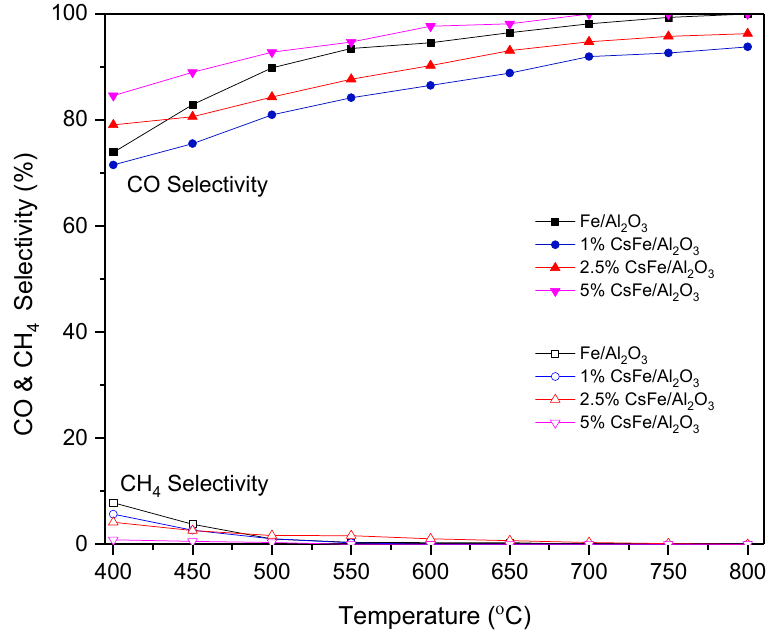
◦ C, WHSV of 12,000 mL/g cat h, and H 2 /CO 2 ratio of